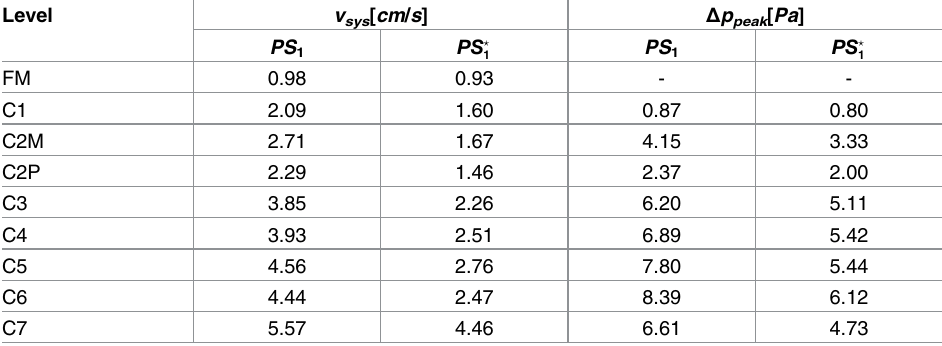
Table 2. Hydrodynamics parameters within each spinal segment resulting from test cases PS 1 and PS